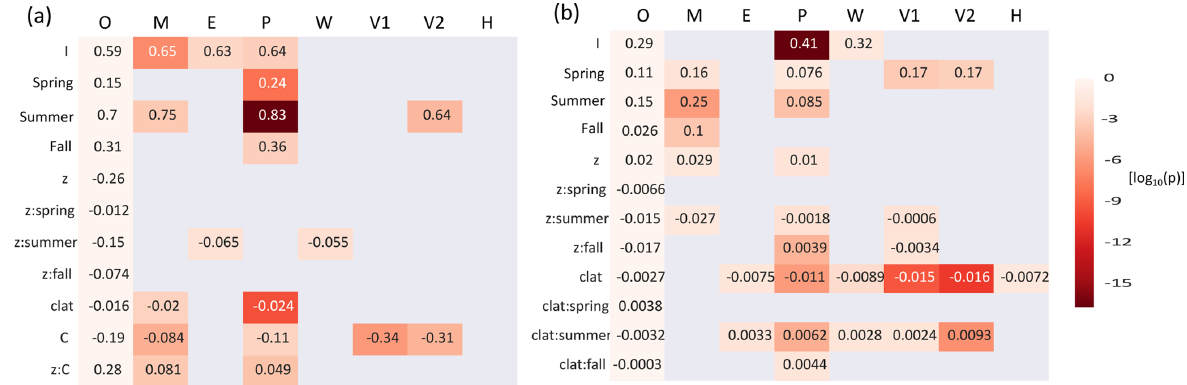
Figure 6. Seasonal and geographical dependencies of seasonal humidity (a) and daily clearness index (b) are depicted. The row names are the names of the coefficients, including the intercept (I), of the multiple linear regression model. The regression coefficients of the observational data are shown in the leftmost column of each plot, while the coefficients found for the model estimates are only shown if they are significantly different from those of the observations (using a limit of p < 0 . 01 for humidity and p < 0 . 05 for CI). Lower p values are indicated with darker colors using a logarithmic color scale (log 10 ( p